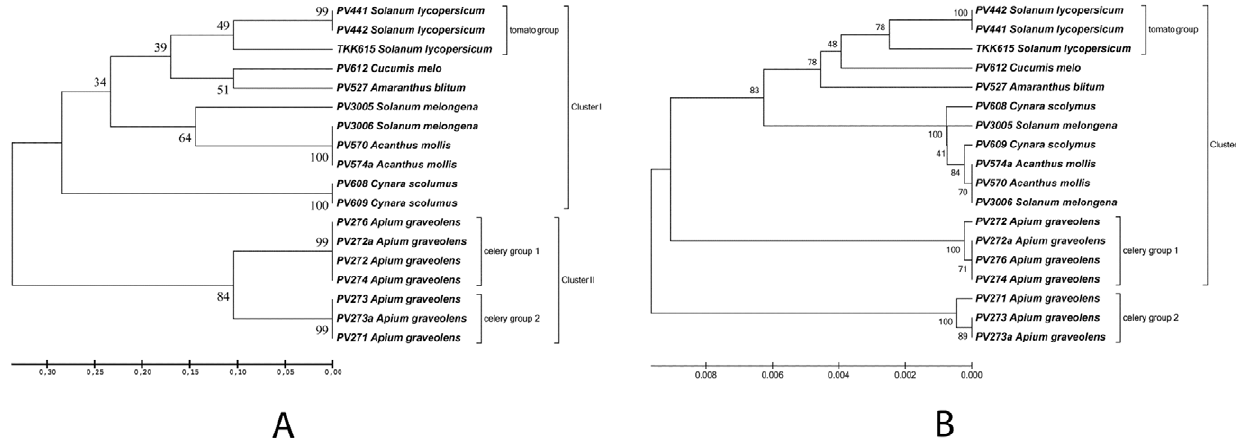
Figure 2. Phylogenetic trees of the local P.viridiflava isolates. The construction of the dendrograms was based on A : BOX- and ERIC-PCR fingerprints (rep-PCR) and B : the combined gyrB, rpoD and rpoB gene sequences. The plant hosts are given next to the code number (PVXXX, see Table 1) of each isolate. The evolutionary history was inferred using the UPGMA method. The consensus tree inferred from 1500 replicates is taken to represent the evolutionary history of the isolates analyzed. Branches corresponding to partitions reproduced in less than 50% bootstrap replicates are collapsed. The percentage of replicate trees in which the associated taxa clustered together in the bootstrap test is shown next to the branches. The tree is drawn to scale, with branch lengths in the same units as those of the evolutionary distances used to infer the phylogenetic tree. The evolutionary distances were computed using the Maximum Composite Likelihood method and are in the units of the number of base substitutions per site. All positions containing gaps and missing data were eliminated. There were a total of 2222 positions in the final dataset. Evolutionary analyses were conducted in MEGA5.